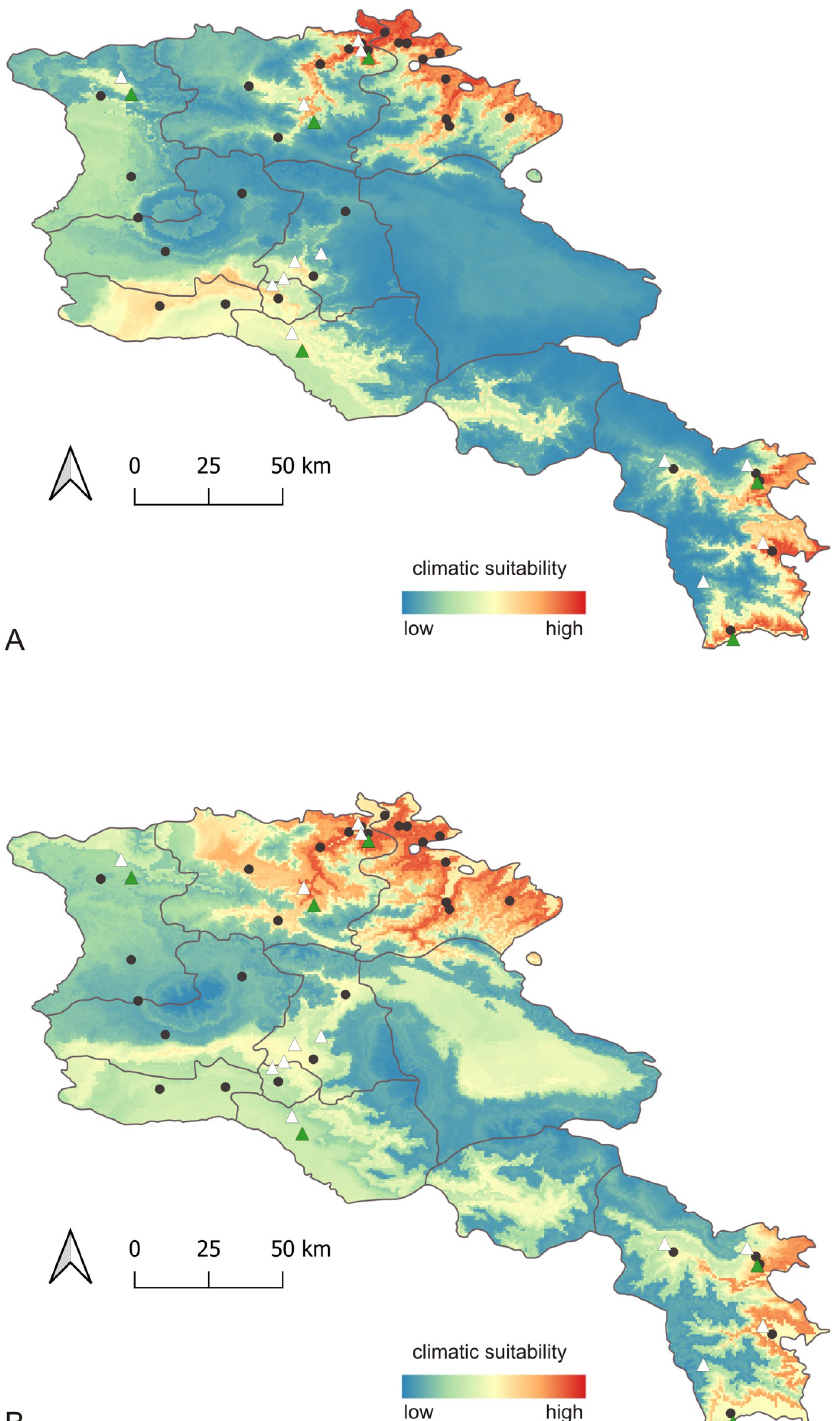
Fig 7. Inference of spatiotemporal projection using correlative ecological niche models for risk assessment of leishmaniasis. Modeled climatic suitability for the vectors transmitting L . infantum—P . balcanicus and P . kandelakii— and risk assessment of visceral leishmaniasis in Armenia (districts are shown). (A) current projection; (B) future projection for 2041–2060. Occurrence of vectors transmitting L . infantum is indicated by green ( P . kandelakii ) and white ( P . balcanicus ) triangles, cases of visceral leishmaniasis by black dots. The map was generated by the use of the shapefile of Armenia available from https://gadm.org/download_country_v3.html.